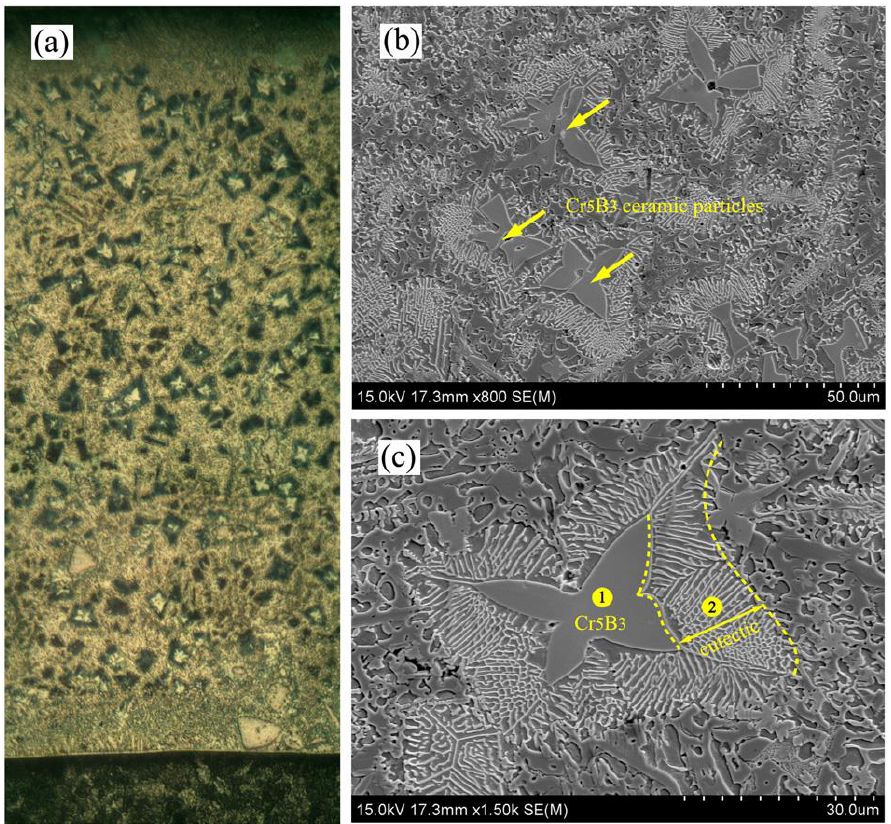
Figure 7: Microstructure of in-situ synthesized ceramic particles in Ni60-20WC coating (a): cross-section; (b): magnified SEM; (c): high magnification microstructure